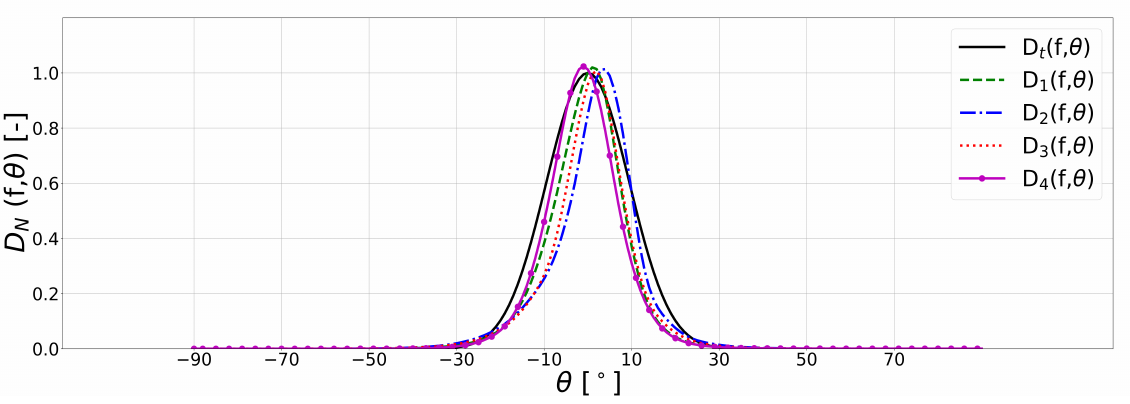
Figure 7. Normalized spreading function distributions D N ( f , θ ) generated at the center of the MILDwave numerical domain for an incident short-crested irregular wave. H s = 2 m and T p = 8 s, and different randomly generated short-crested sea states are used with s 1 =